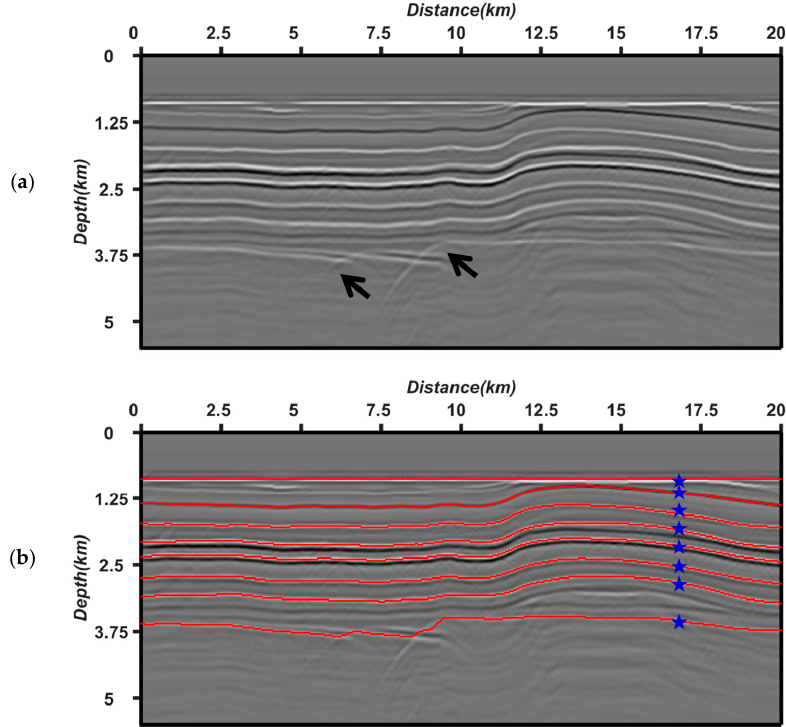
Figure 7. The overthrust model result. ( a ) Seismic image and ( b ) tracked horizons (red curve) overlaid with the seismic image.